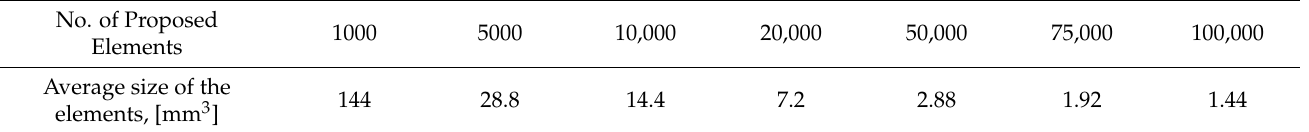
Table 2. Average size of the